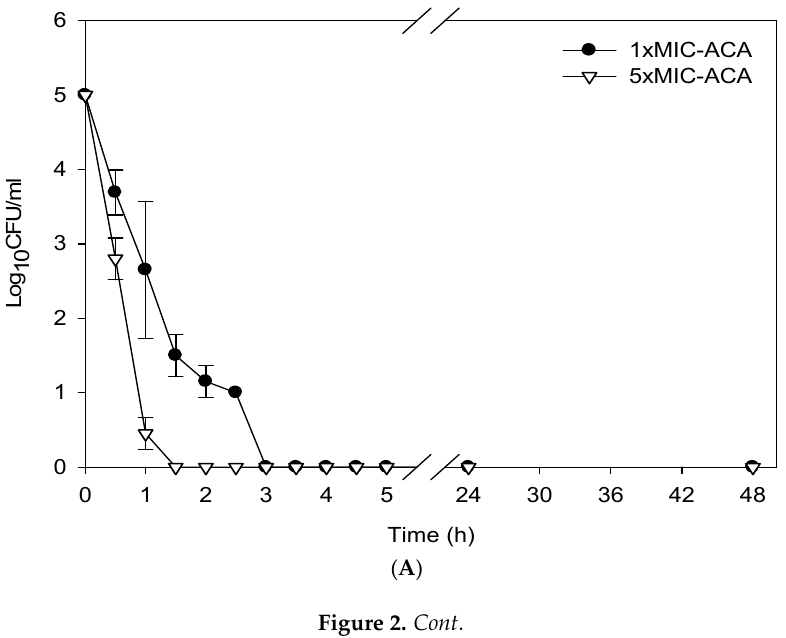
Table 3. MICs of rac -ACA against drug-resistant clinical M. tuberculosis isolates obtained from Siriraj